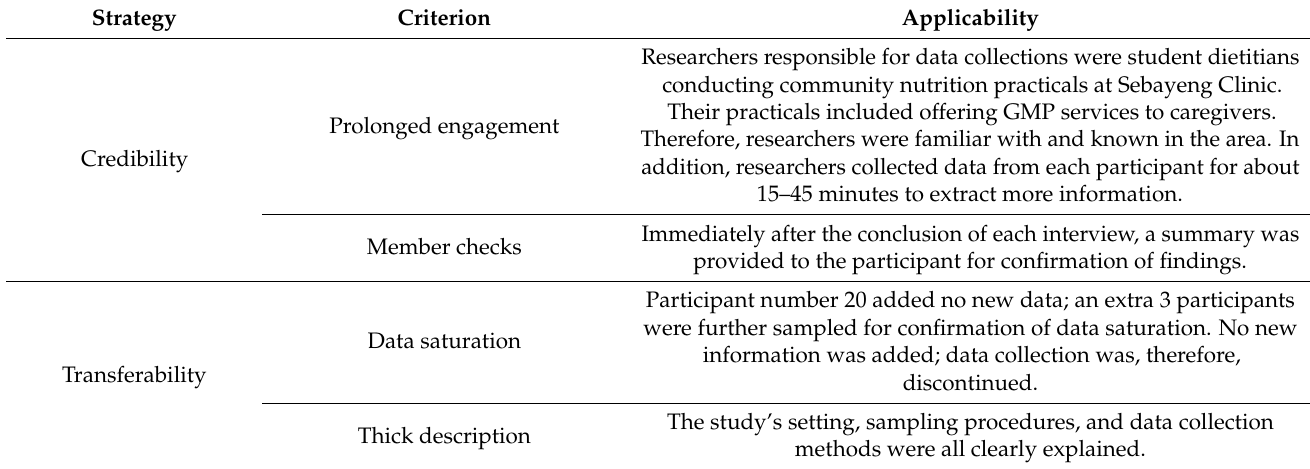
Table 1. Measures of